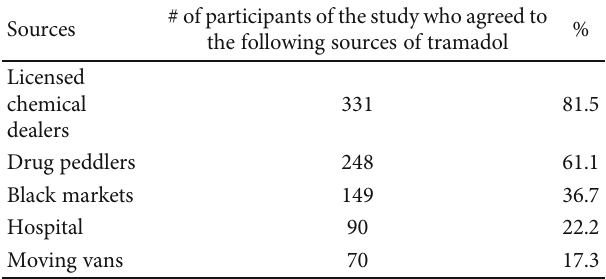
Table 4: Sources of tramadol.